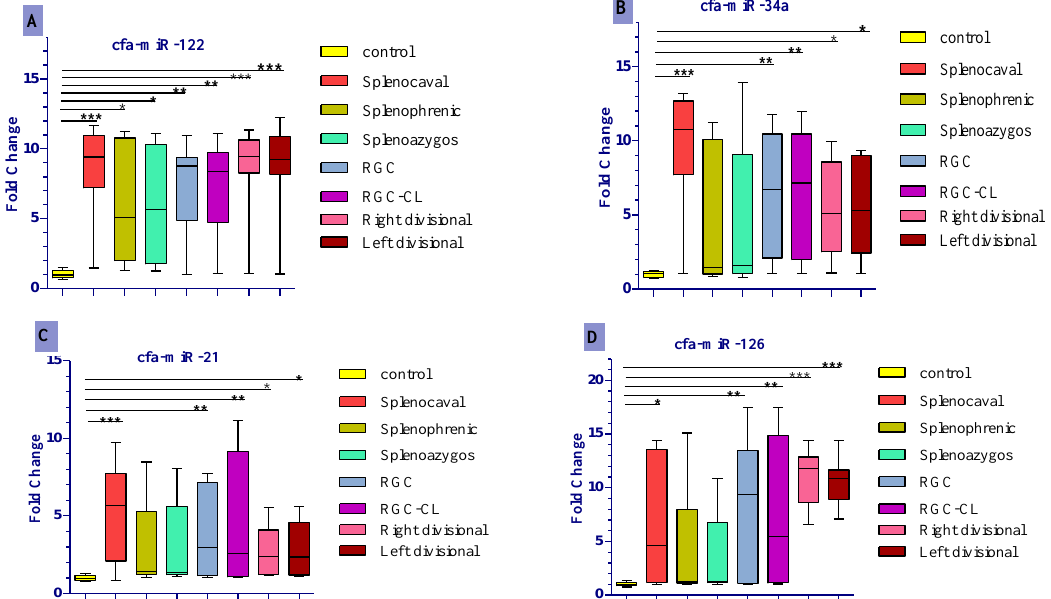
Figure 3. Comparison of expression level of cfa-miR- 122 ( A ), cfa-miR- 34a ( B ), cfa-miR-21 ( C ),